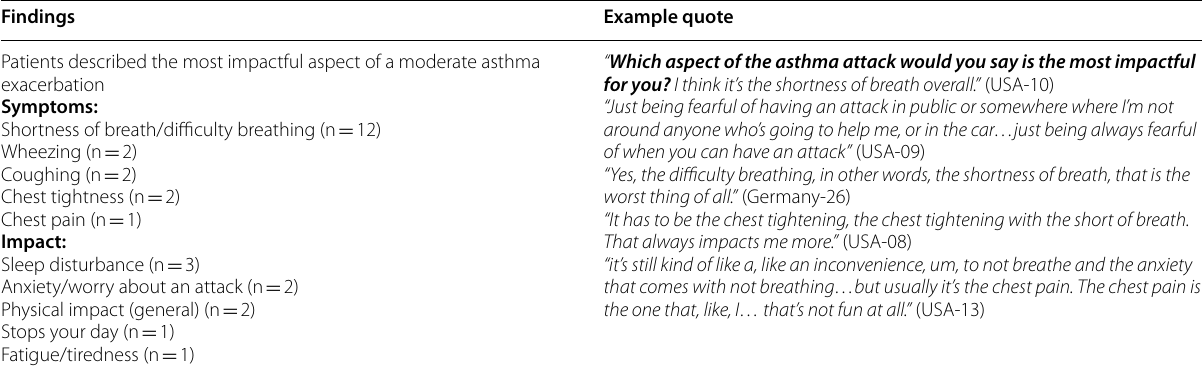
Table 4 Patient quotes of the most impactful aspect of a moderate asthma exacerbation